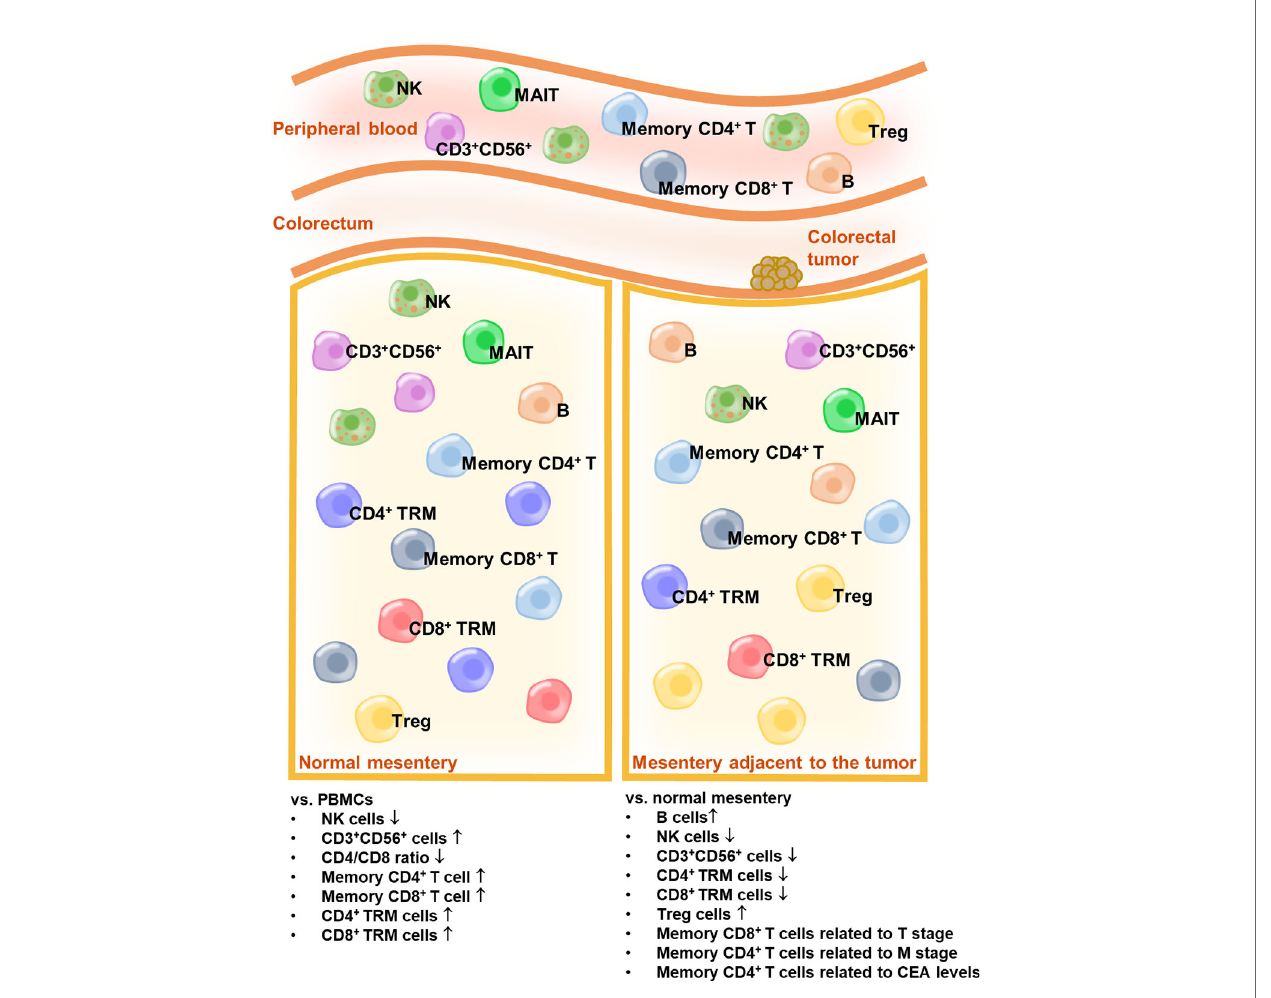
FIGURE 6 | The schema of the immune landscapes of the PB, the MES N, and MES T in patients with